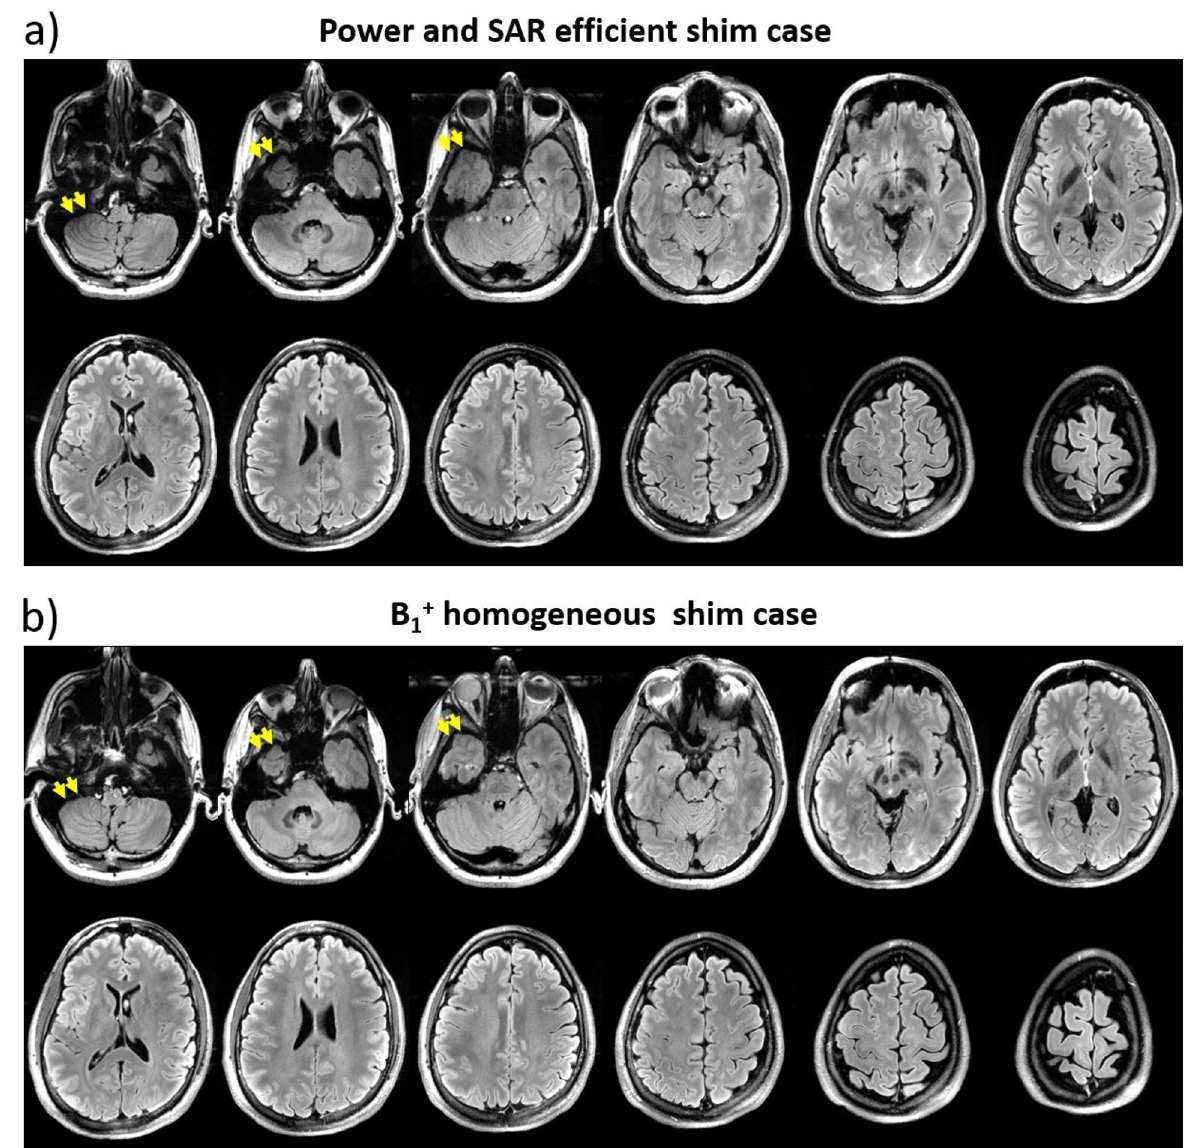
Figure 6. Axial slices of the FLAIR images acquired at resolution of 0.7 × 0.7 × 2 mm 3 . The images show the differences between the power and SAR efficient ( a ) and B 1+ homogeneous ( b ) shim cases. The yellow arrows point to the regions where the dropout was mitigated by the B 1+ homogeneous case. The parameters of the acquisition were: TE/TI/TR = 103/2900/13,500 ms, acceleration factor 2, BW = 230 Hz/Px, transversal acquisition of 64 slices, field of view 224 × 176.4 mm 2 in axial plane, and acquisition time = 7:36